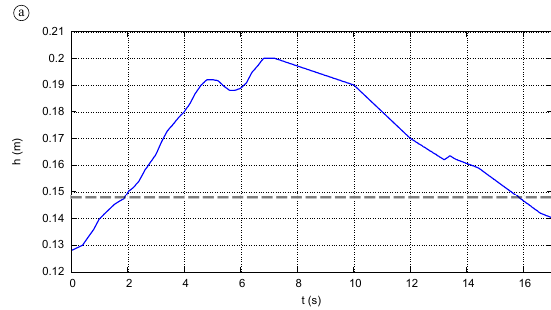
Figure 7. Upstream (a) and downstream (b) pressured head level.